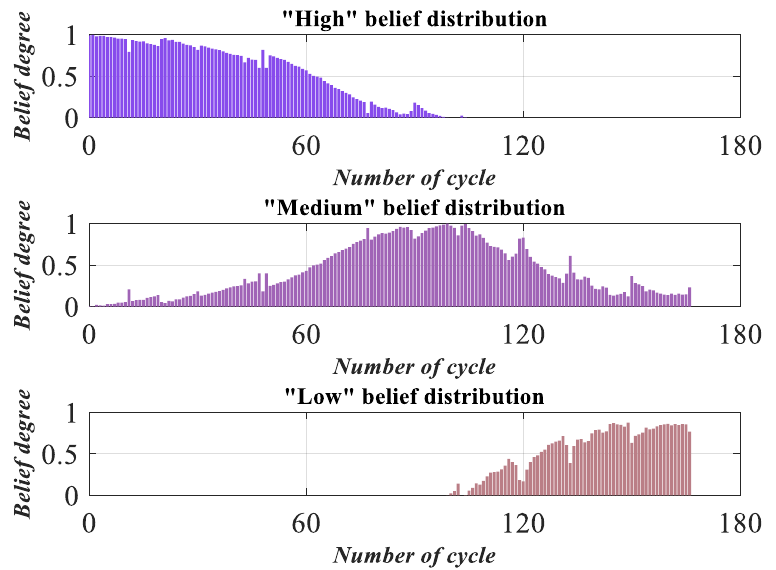
Figure 7. Health assessment result of a lithium-ion battery.